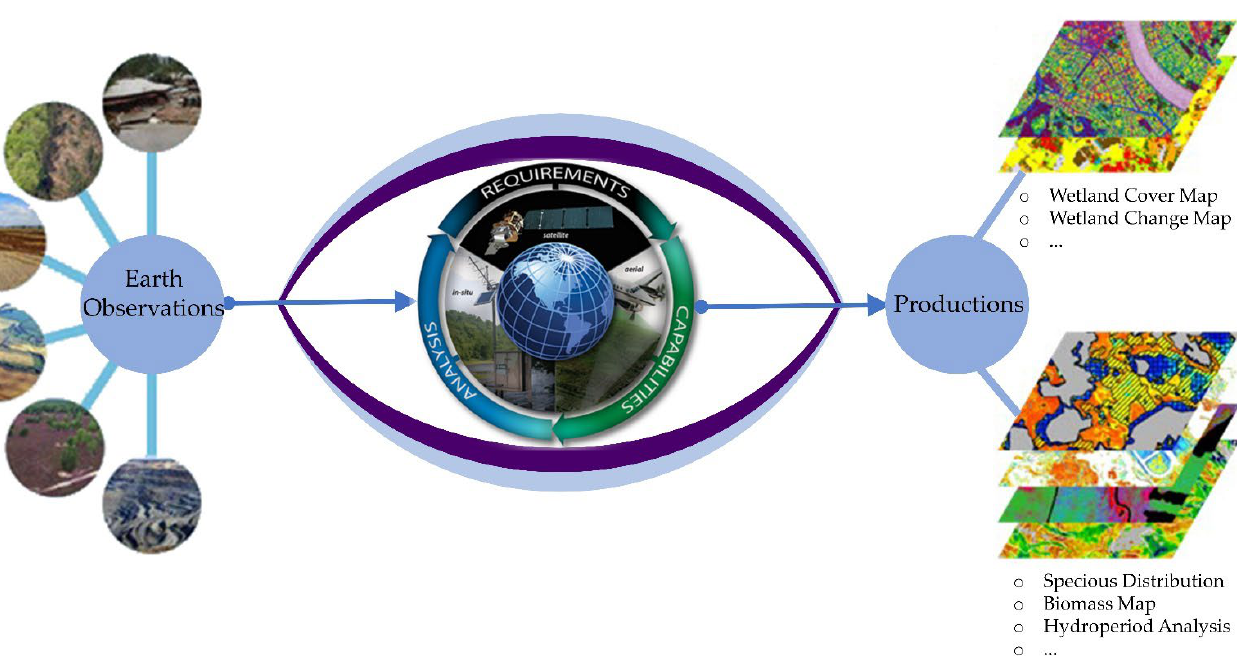
Figure 1. A conceptual overview of the use of ML and RS tools to derive